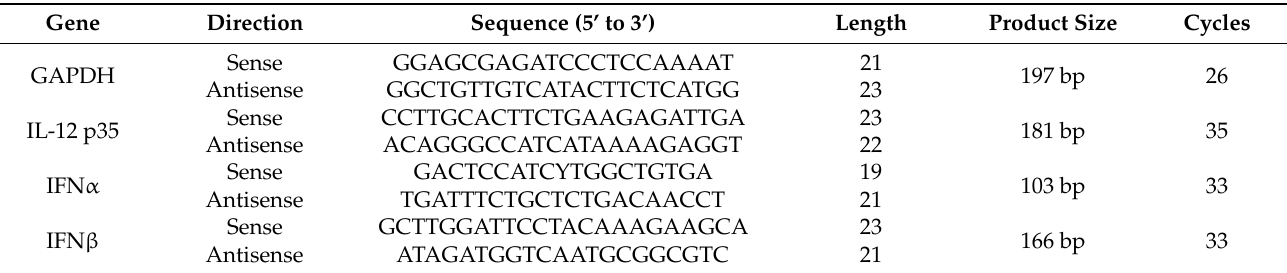
Table 1. PCR primer sequences for cytokines expression